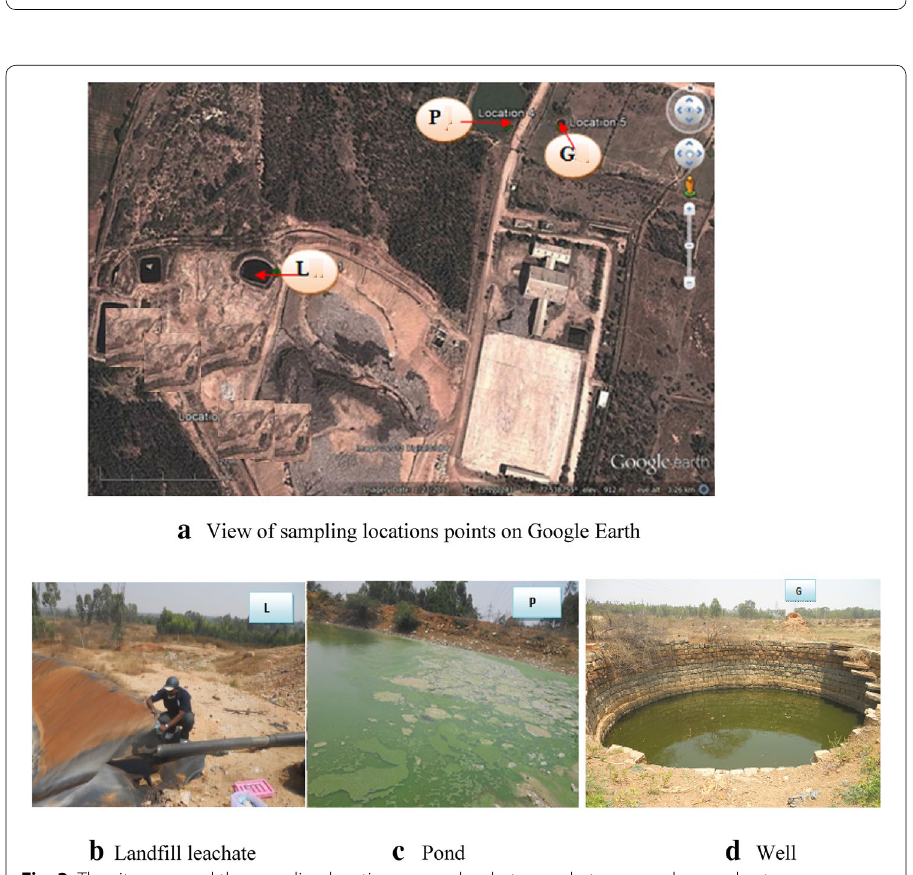
Fig. 3 The site map and the sampling locations across leachate pond, storage and groundwater